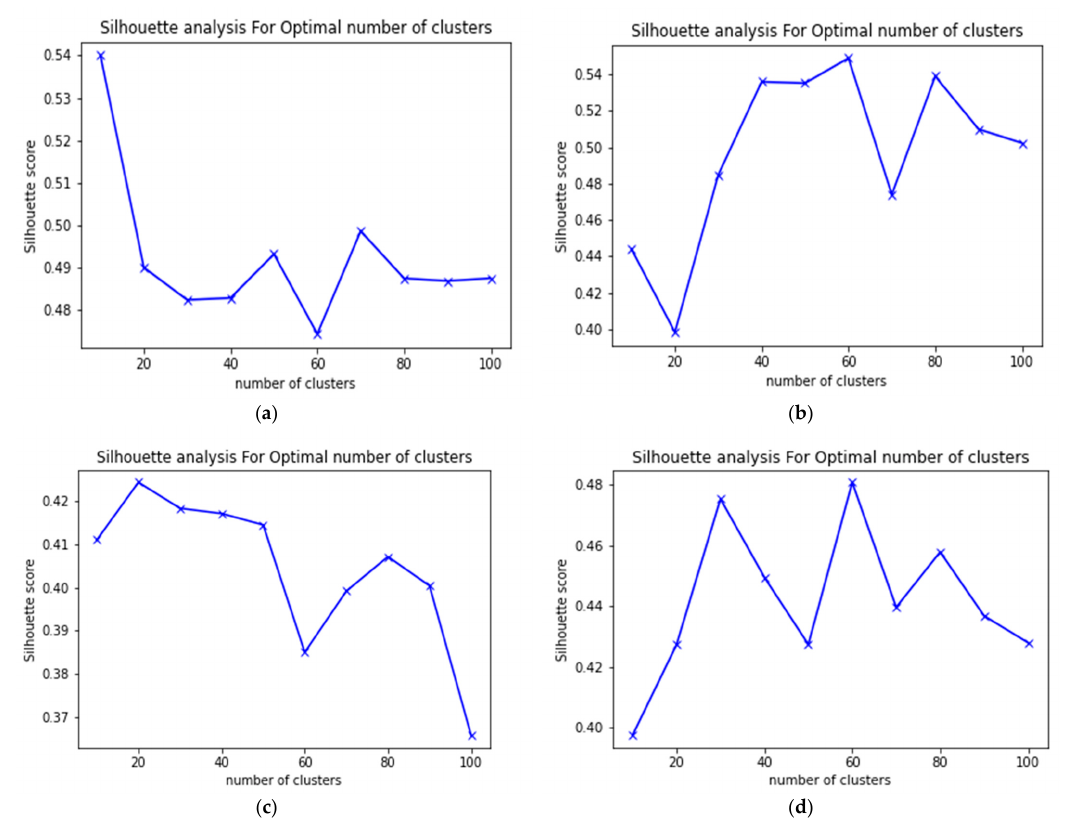
Figure 6. Silhouette values registered by fuzzy K-means algorithm for different cluster numbers in sequences 0001, 0034, 0027, and 0053 from the Kitti dataset. ( a ) Silhouette values in sequence 0001. ( b ) Silhouette values in sequence 0034. ( c ) Silhouette values in sequence 0027. ( d ) Silhouette values in sequence 0053.